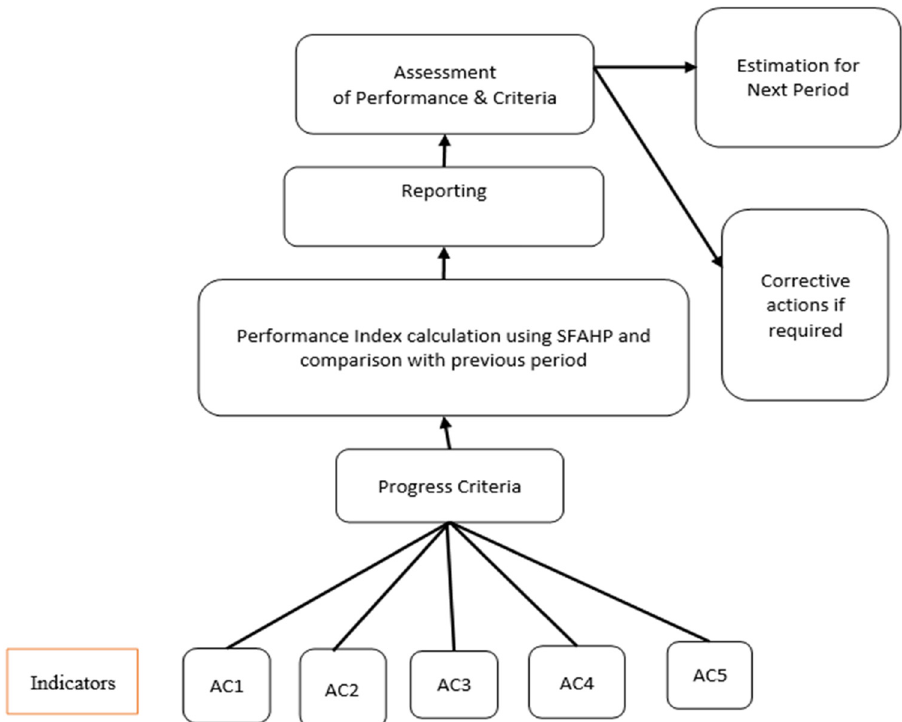
Figure 6: Periodical reporting and assessment during construction project life